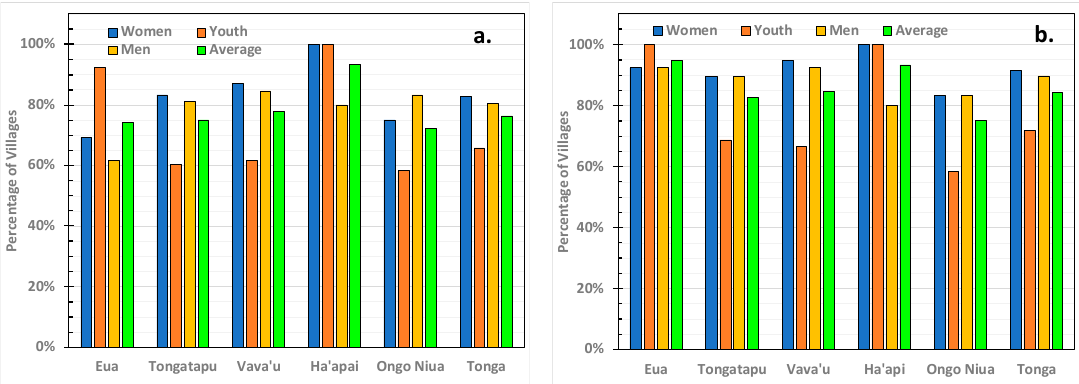
Figure 5. The percentage of villages throughout Tonga’s Island Divisions, as well as Tonga collectively, which ranked water supply: ( a ) within the top three priorities; and ( b ) as a priority in terms of women’s, youths’ and men’s perspective and the village average of all three.